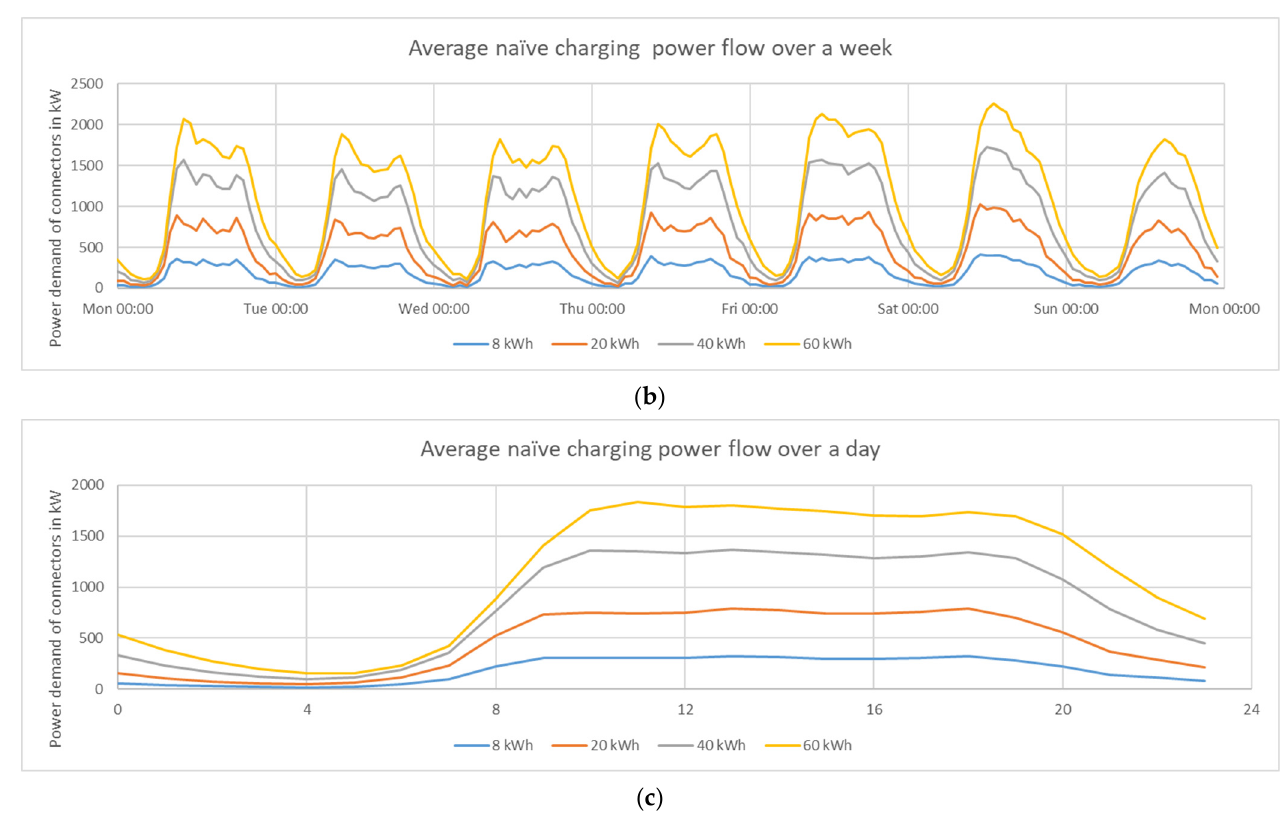
Figure 9. Power demand using the naive charging strategy for the 1562 connectors with a total power of ~34 MW observed in this study: ( a ) the power flow over the entire simulated timeframe; ( b ) the average of ( a ) over a week; ( c ) the average of ( a ) over a day. The plot is structurally very similar to Figure 5.